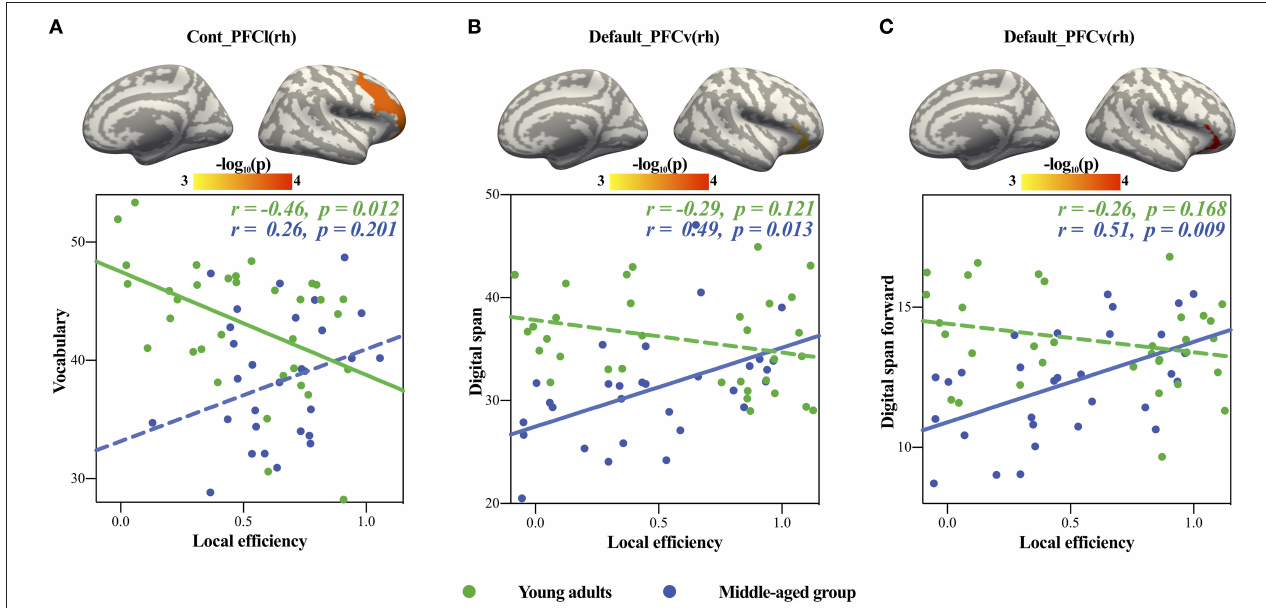
FIGURE 3 | Significant age × local efficiency interactions in cognitive intelligence. The upper panels showed the locations of brain regions with significant age × local efficiency interactions, and the panels below showed scatters of each significant interaction. (A,B) showed volume network, and (C) showed area network. The solid lines represented the statistically significant subgroup correlations, whereas the dashed lines represented the subgroup correlations that did not pass the significance test or the FDR